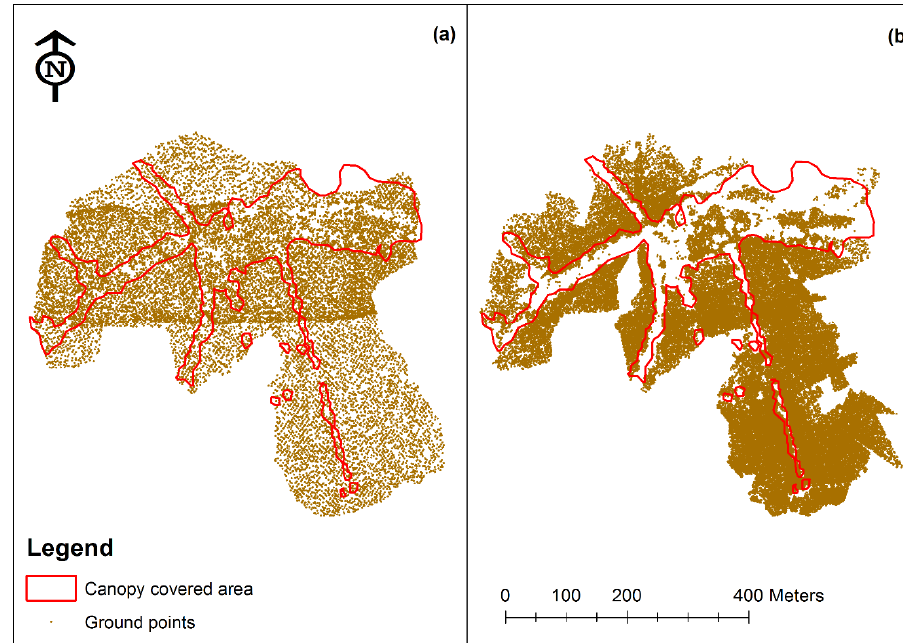
Figure 6. Showing ( a ) LiDAR ground points and ( b ) SfM ground points at the Meshaw site. Point density in canopy areas was 0.27 points/m 2 for LiDAR and 1.56 points/m 2 for SfM.